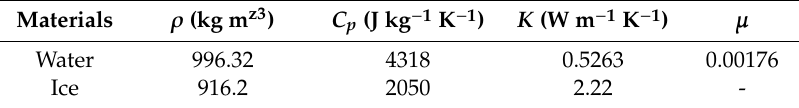
Table 2. Thermo-physical properties of water (0.5 ◦ C, 0.1 MPa) and ice (0 ◦ C)